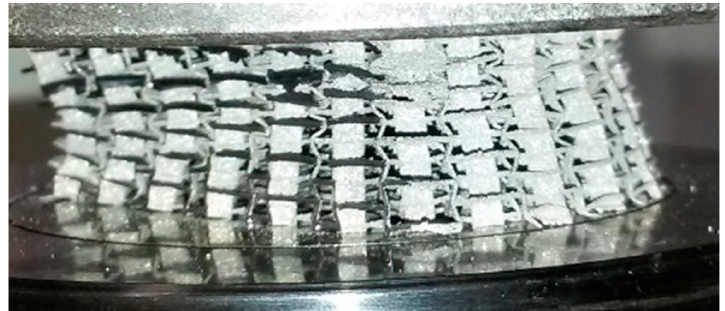
Figure 22. Actual deformation in FCC during compression testing. Areas of diagonal shear collapse have been highlighted faintly in red.